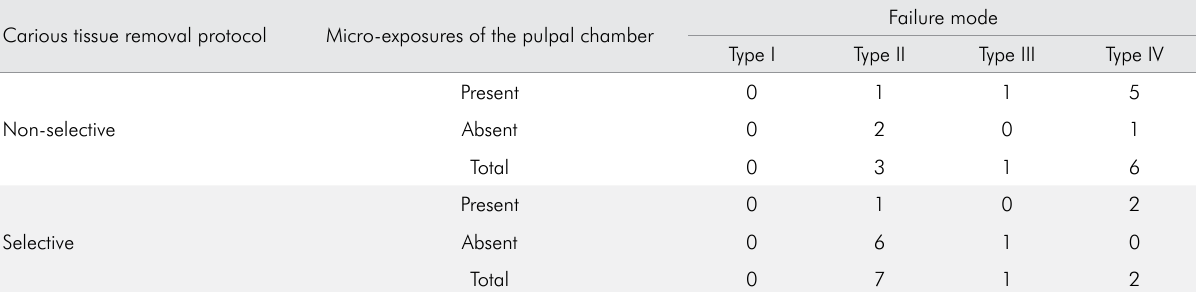
Table 2. Failure mode according to the carious tissue removal protocol and the presence of micro-exposures of the pulpal chamber. Carious tissue removal